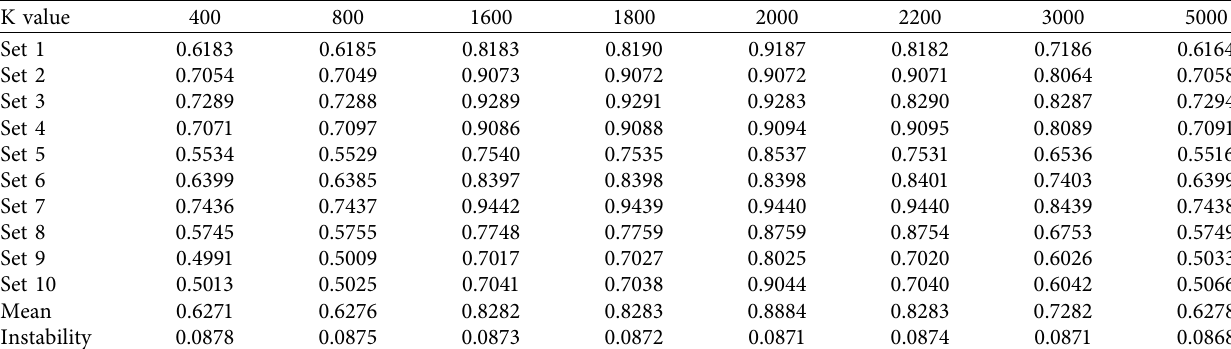
Table 4: Grid search cross-verifies the prediction accuracy in each